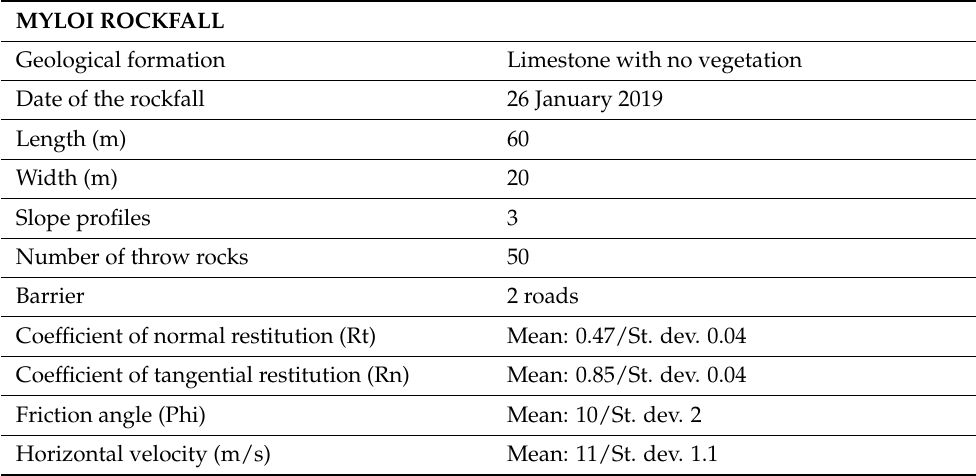
Table 3. Geological and material